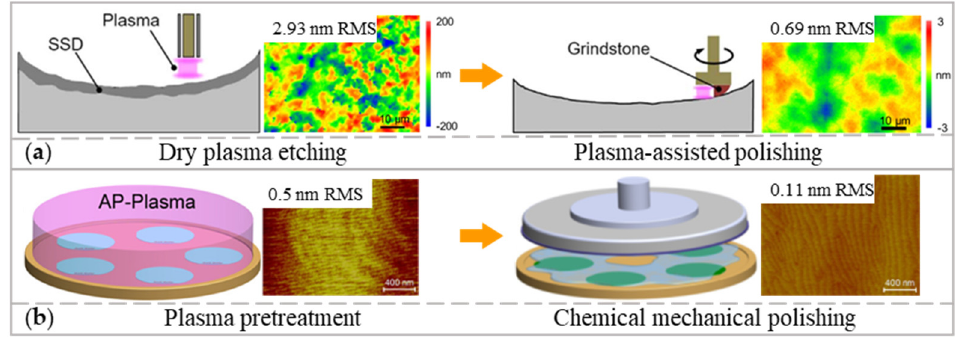
Figure 13. The combined process of the plasma treatment with ( a ) dry plasma etching. Reproduced with permission from [101]; ( b ) CMP. Reproduced with permission from [102].